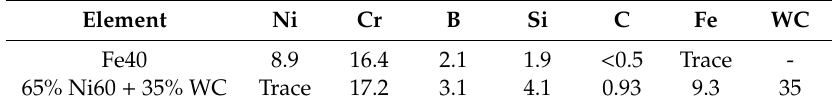
Table 1. Main chemical composition of the coated powder material (wt.%).